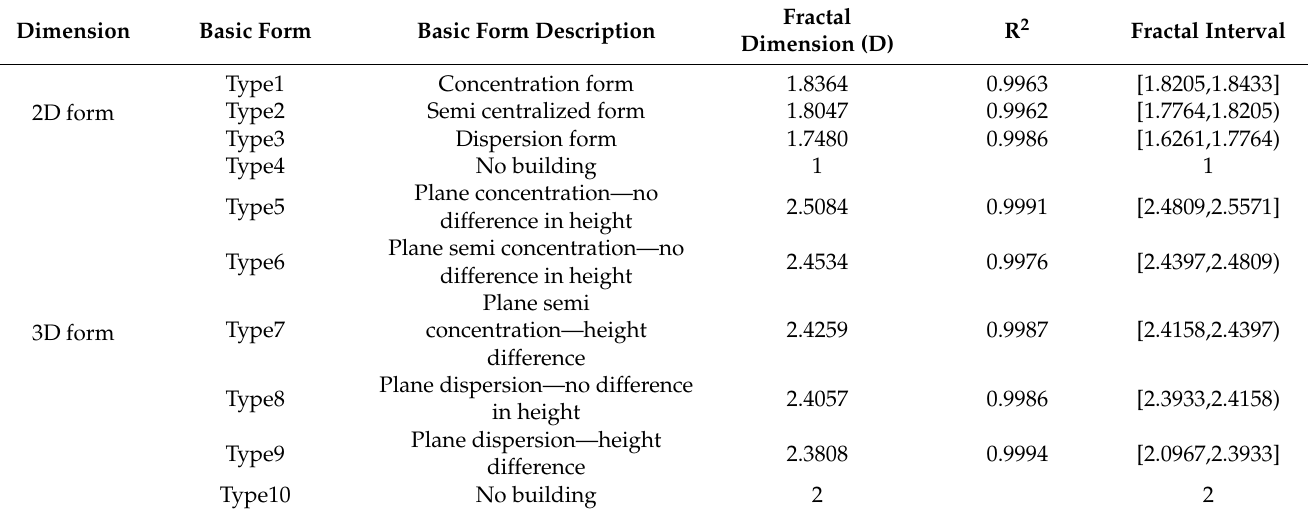
Table 1. Fractal interval division based on basic architectural